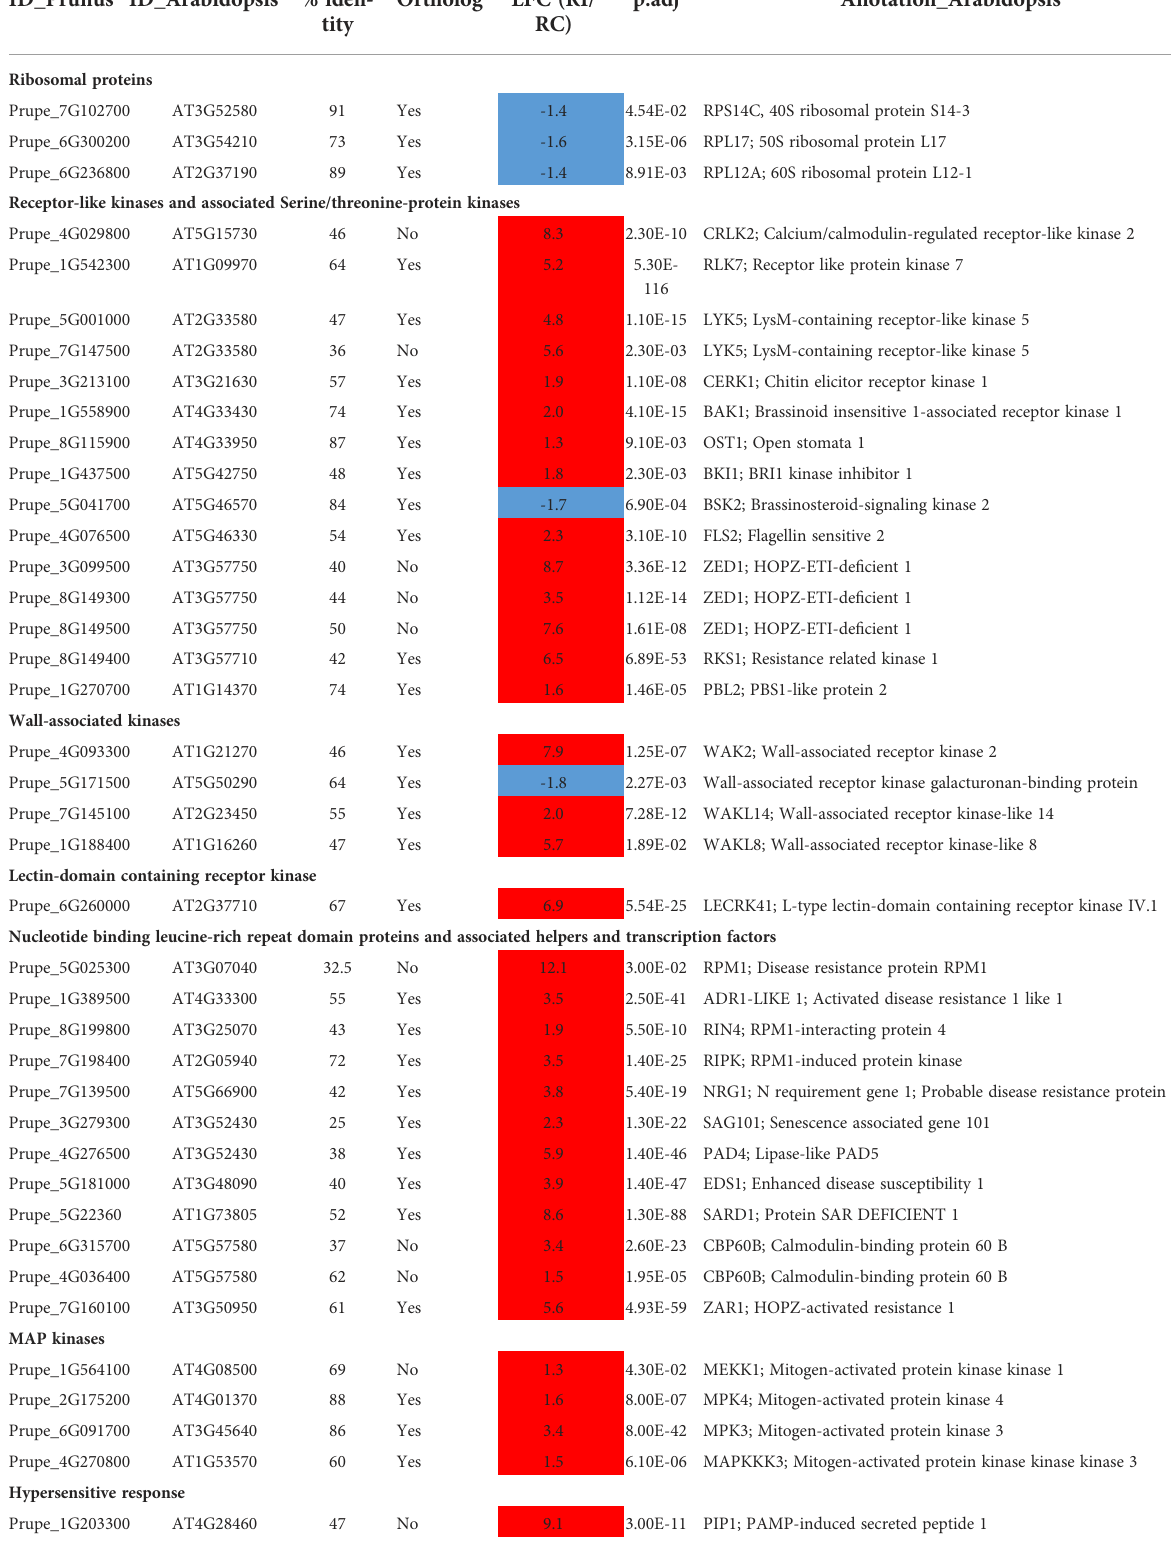
TABLE 1 Selection of DEGs in the resistant genotype Rubira after GPA infestation, cited in the text and fi gures. ID_Prunus ID_Arabidopsis % iden-